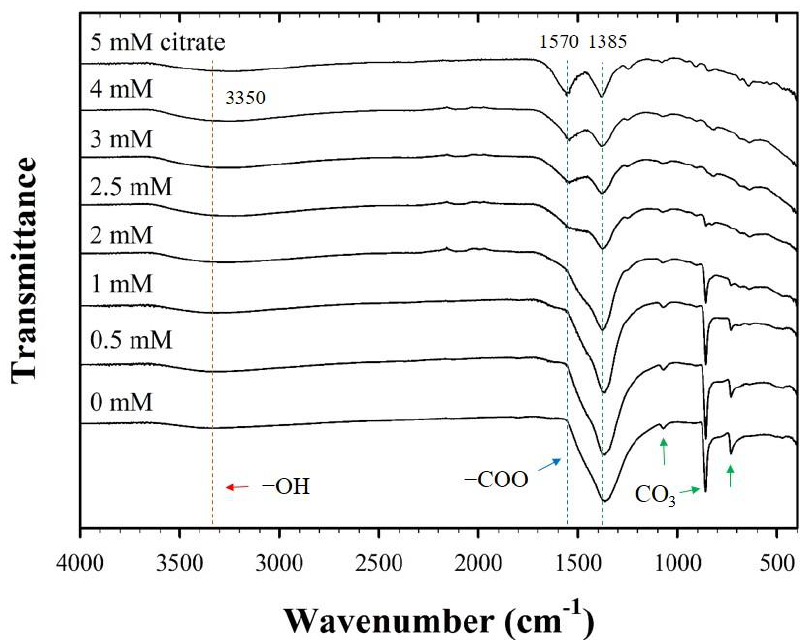
Figure 3. Fourier transform-infrared (FT-IR) spectra for the CF-NCs synthesized in the presence of different citrate concentrations (0–5 mM).